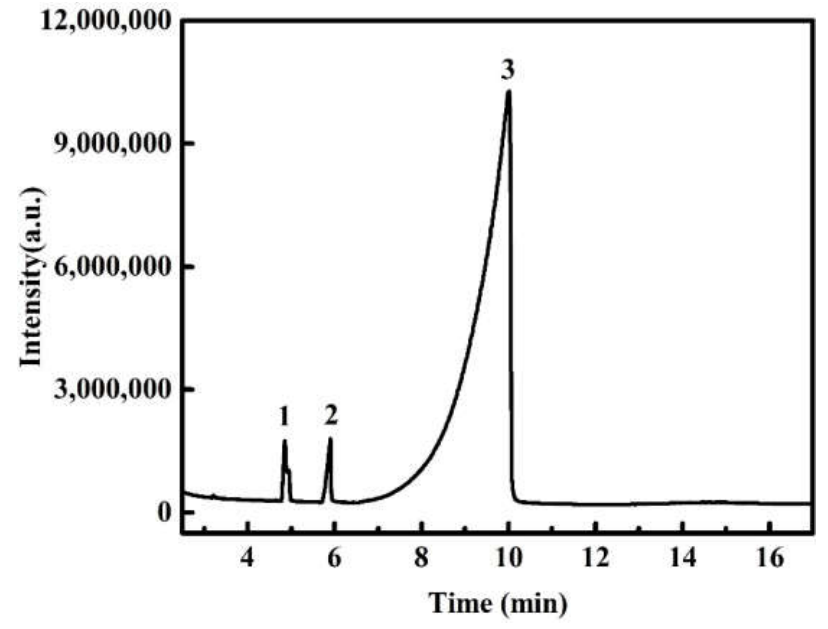
Figure 2. GC-MS spectra of Fr 3; 1: succinic anhydride; 2: mono-methyl succinate; 3: succinic acid. Table 3. Identified components from Fr 3 by GC-MS analysis. Peak